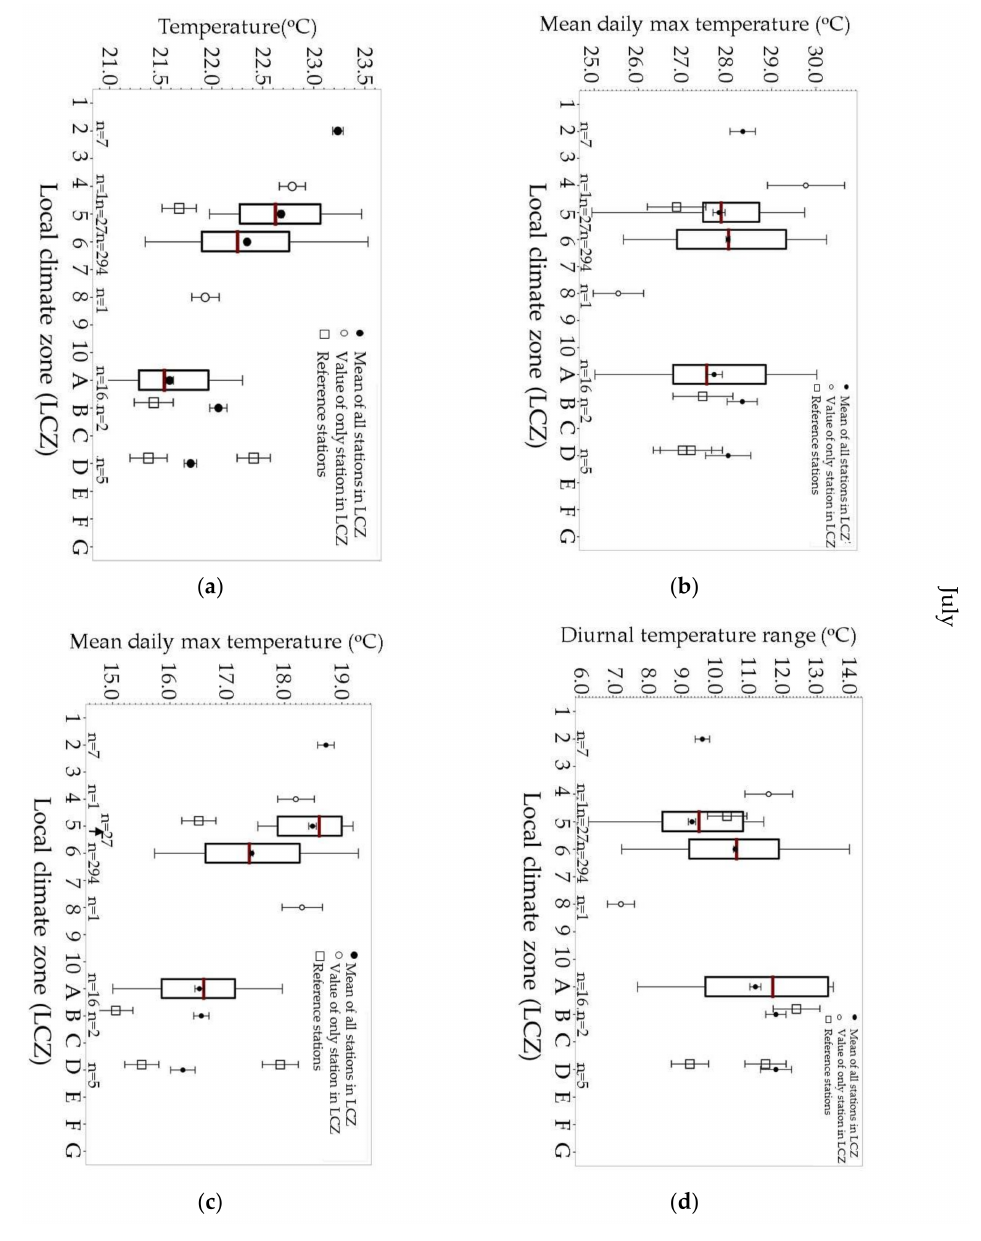
Figure 5. Local climate zone (LCZ) temperature characteristics in July 2018: ( a ) is the mean temperature over the entire month, ( b ) is the mean daily maximum temperature, ( c ) is the mean daily minimum temperature, and ( d ) is the mean diurnal temperature range. LCZs associated with urban landscapes (LCZs 1-10) are on the left side and those associated with rural landscapes (LCZs A–G) are on the right side. n represents the number of valid stations in that LCZ. Filled dots represent the mean of all Netatmo stations in each LCZ, unfilled dots represent the value of the only Netatmo station in an LCZ and squares represent values of reference stations. Box plots are also displayed for LCZs with more than ten stations present. The maroon central line represents the median, the upper and lower bands of the box are the 75th and 25th percentiles and the upper and lower whiskers are the 95th and 5th percentile. The method of error calculation of the means is shown in Appendix